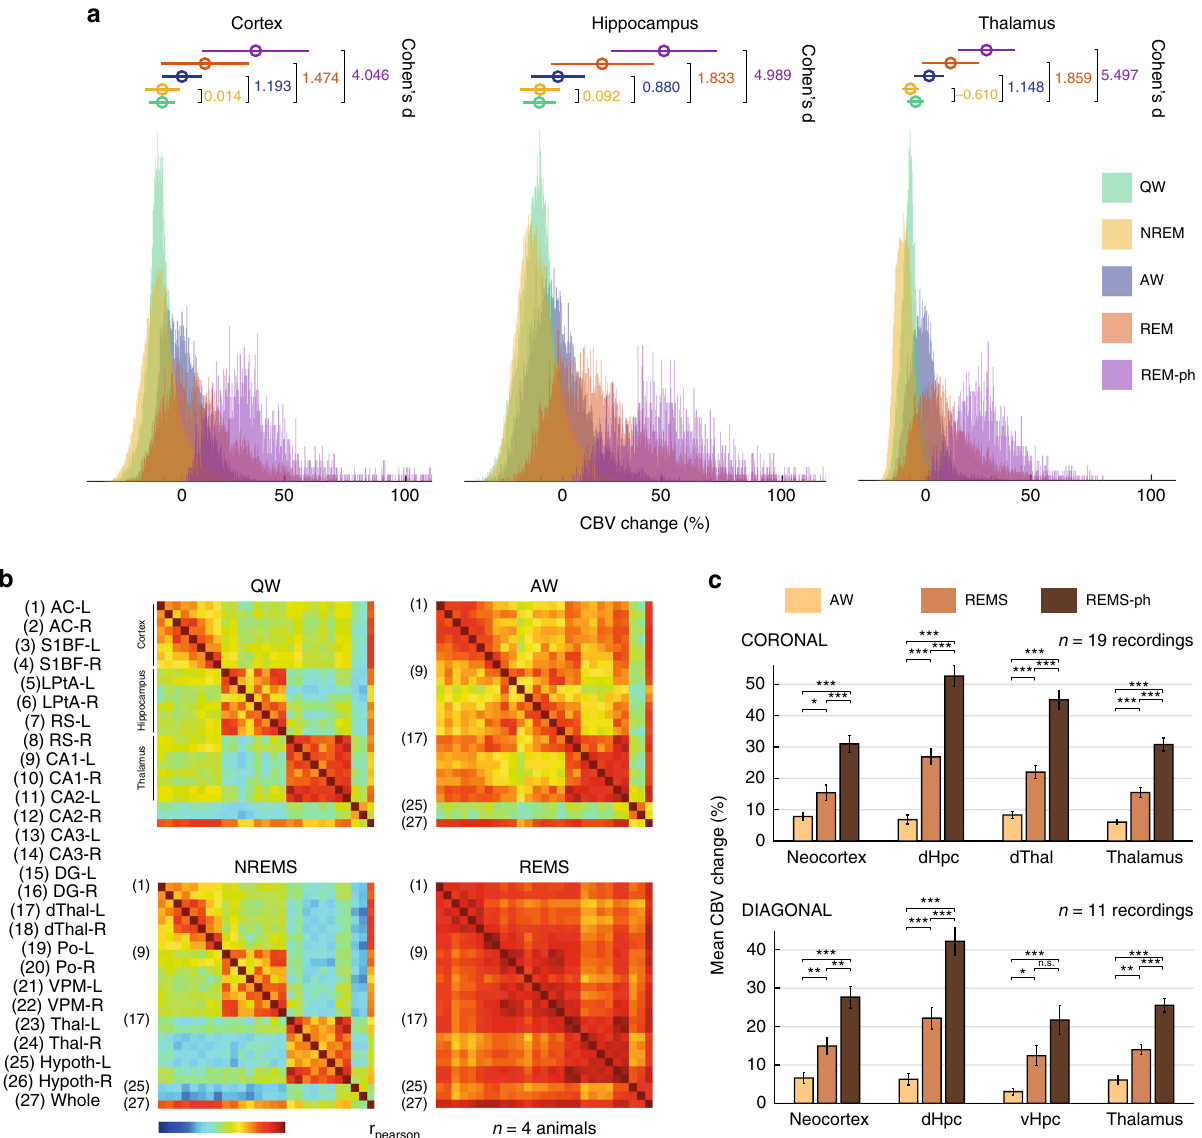
Fig. 2 REMS hyperemia is generalized but strongest in the hippocampus. a Vascular distributions for all animals in three regions (cortex, hippocampus, thalamus) for fi ve different states: quiet wake (QW), active wake (AW), non-REM sleep (NREMS), REM sleep (REMS), and phasic REM sleep (REMS-ph). QW and NREM overlap except in the thalamus. AW is an intermediate state between QW and REM. Hippocampus shows the clearest separation between AW, REMS, and REM-phasic distribution. Horizontal axis: CBV amplitude (% from baseline). Vertical axis: Event count. Circles and horizontal bars show the mean and standard-deviation for each behavioral state. Cohen ’ s d relative to QW are given for all three regions. b Functional connectivity matrices for all four sleep stages, averaged over all recordings ( n = 4 animals). Each matrix displays the Pearson correlation between all pairs of regional CBV variables. Note the similarity between QW and NREM consisting of three co-active blocks including cortical, hippocampal, and thalamic regions and the gradual synchronization of all regional signals during AW and REMS. c Vascular ampli fi cation obtained by averaging AW, REMS, and REMS-ph mean values (Cortex, Hippocampus, Thalamus, and Whole) for all recordings, grouped by recording plane. Strikingly, all four regions consistently display vascular ampli fi cation, with highest ratio obtained by comparing phasic REMS (REMS-ph) and quiet wake (QW) in the dorsal